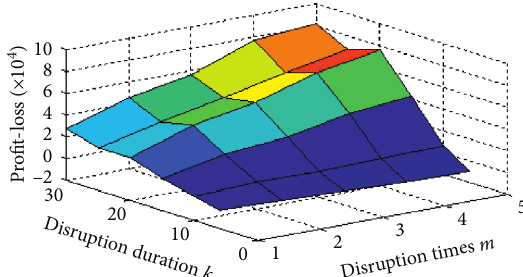
Figure 6: Sensitivity of the manufacturer’s profit loss risks to the duration and times of supply disruptions.